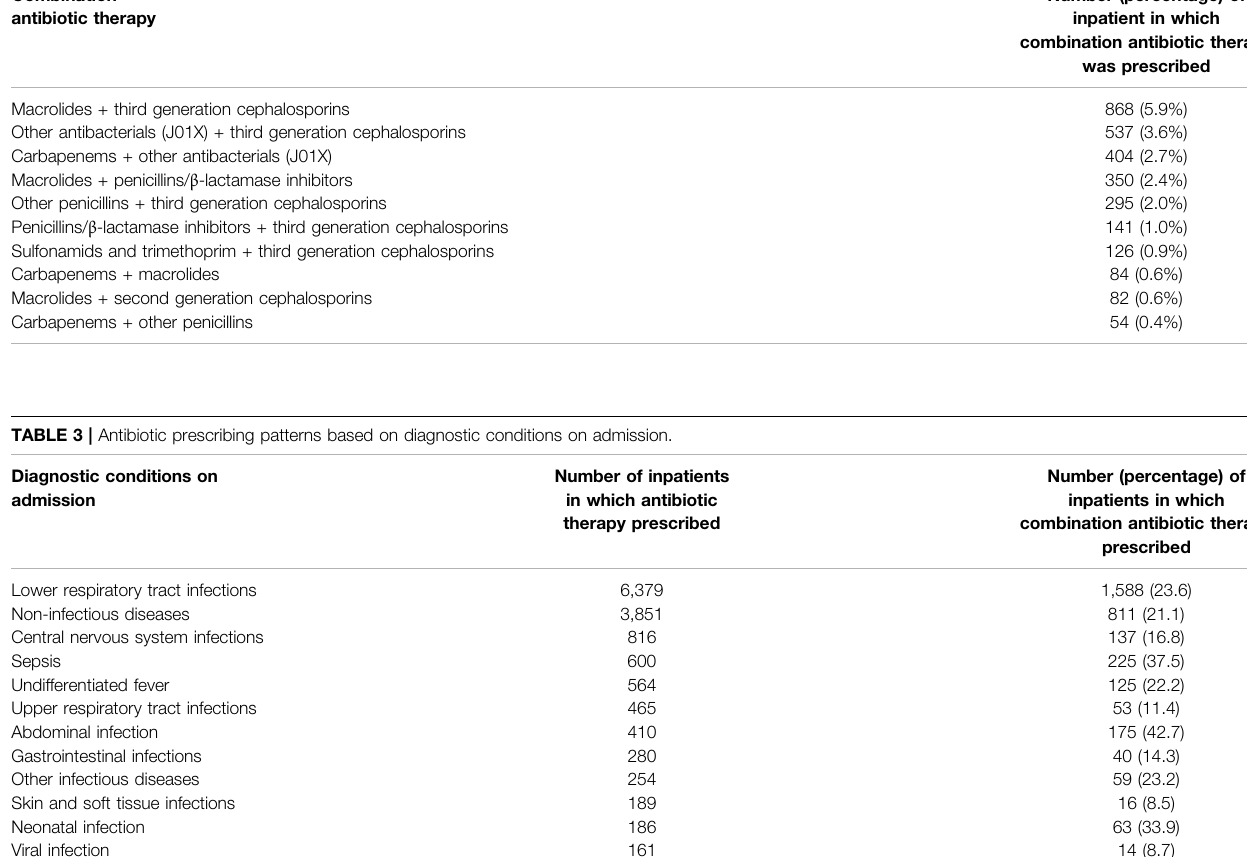
TABLE 2 | Number (percentage) of inpatients in which combination antibiotic therapy was prescribed (Top 10). Combination antibiotic therapy